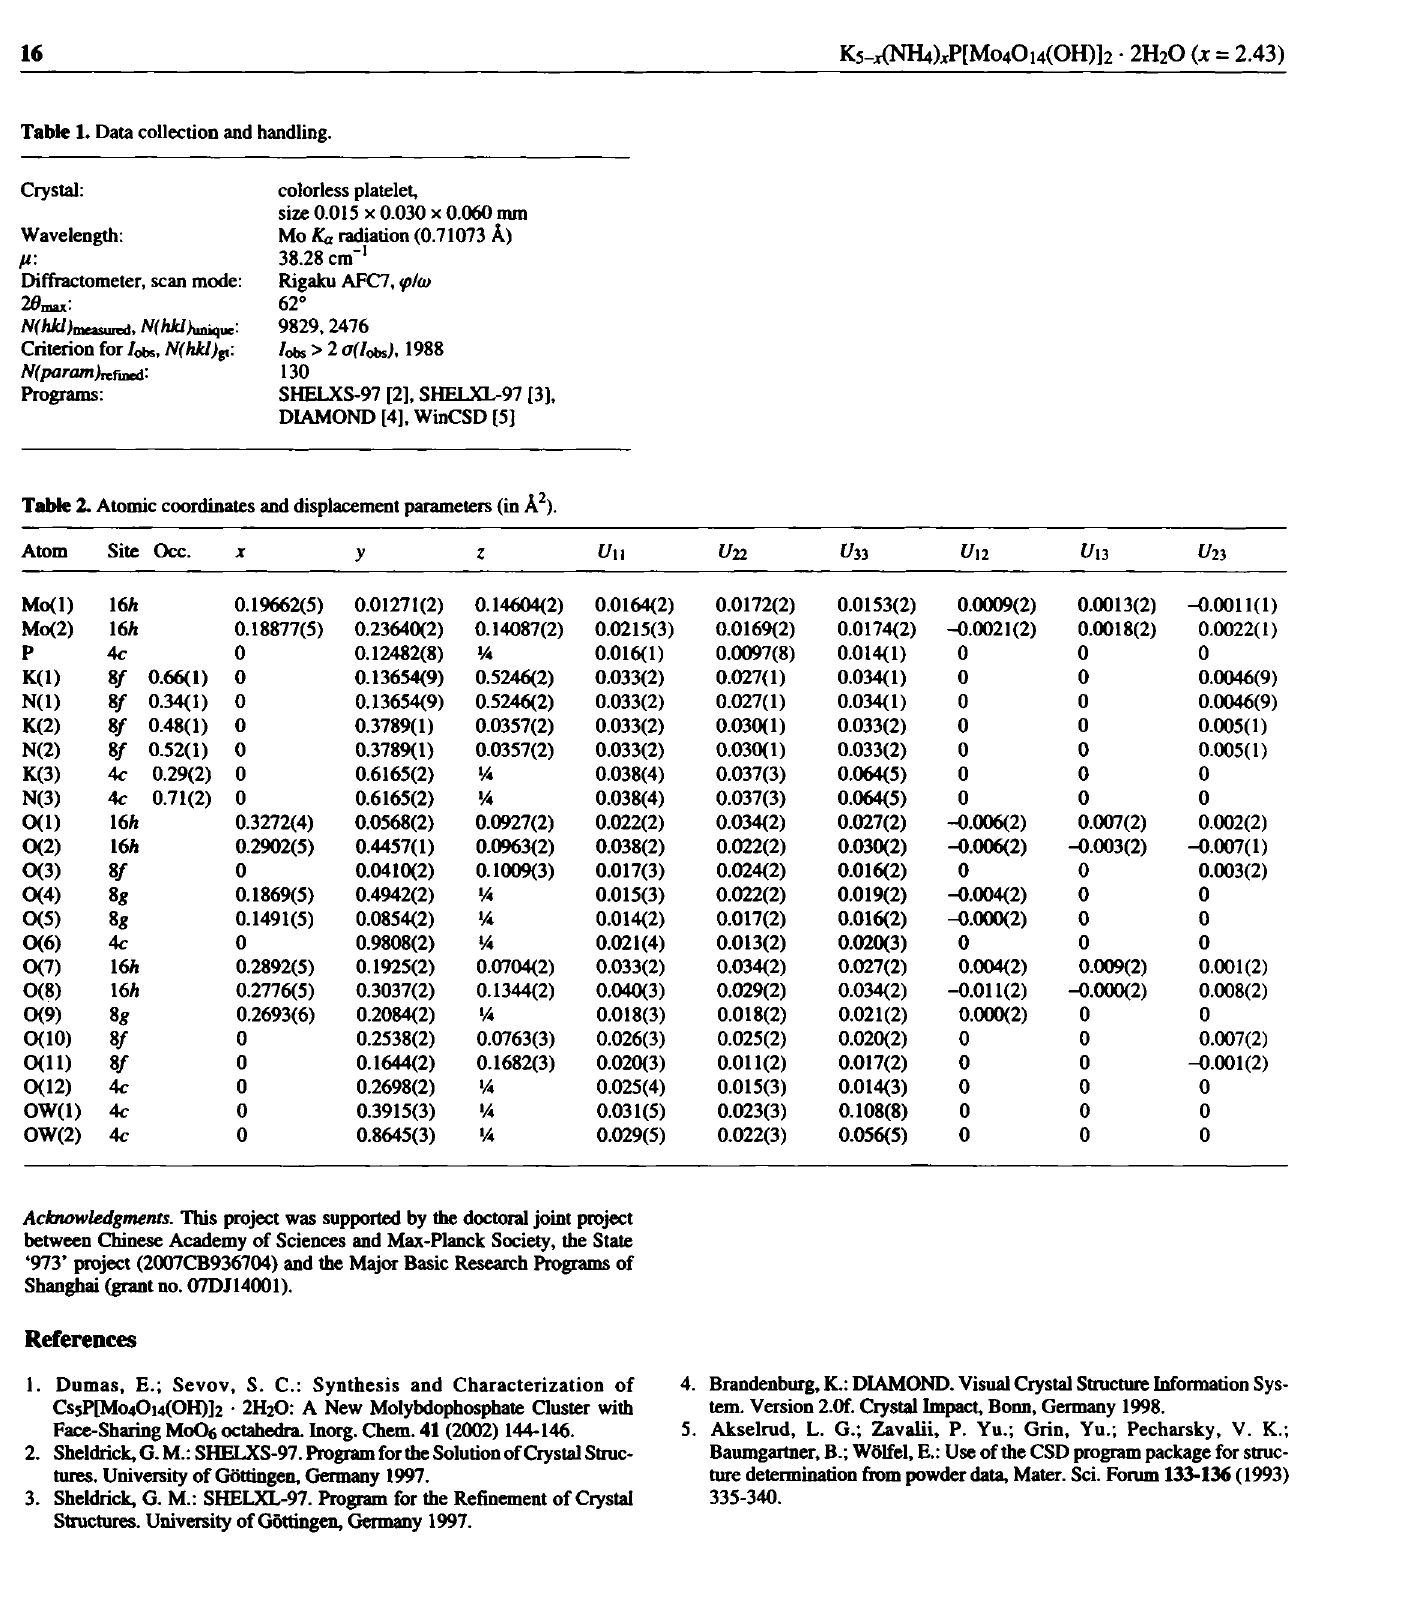
Table 1. Data collection and handling.